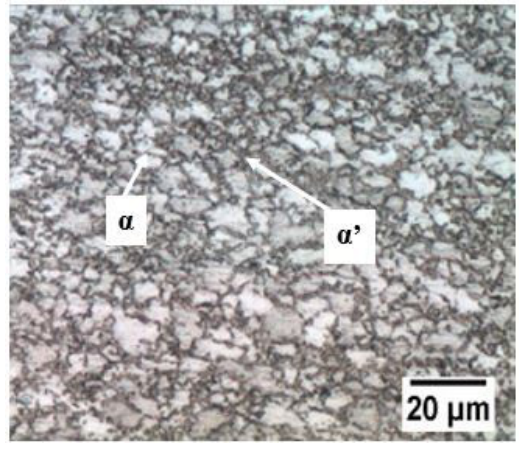
Figure 8: Optical microstructure of AHSS-DP800